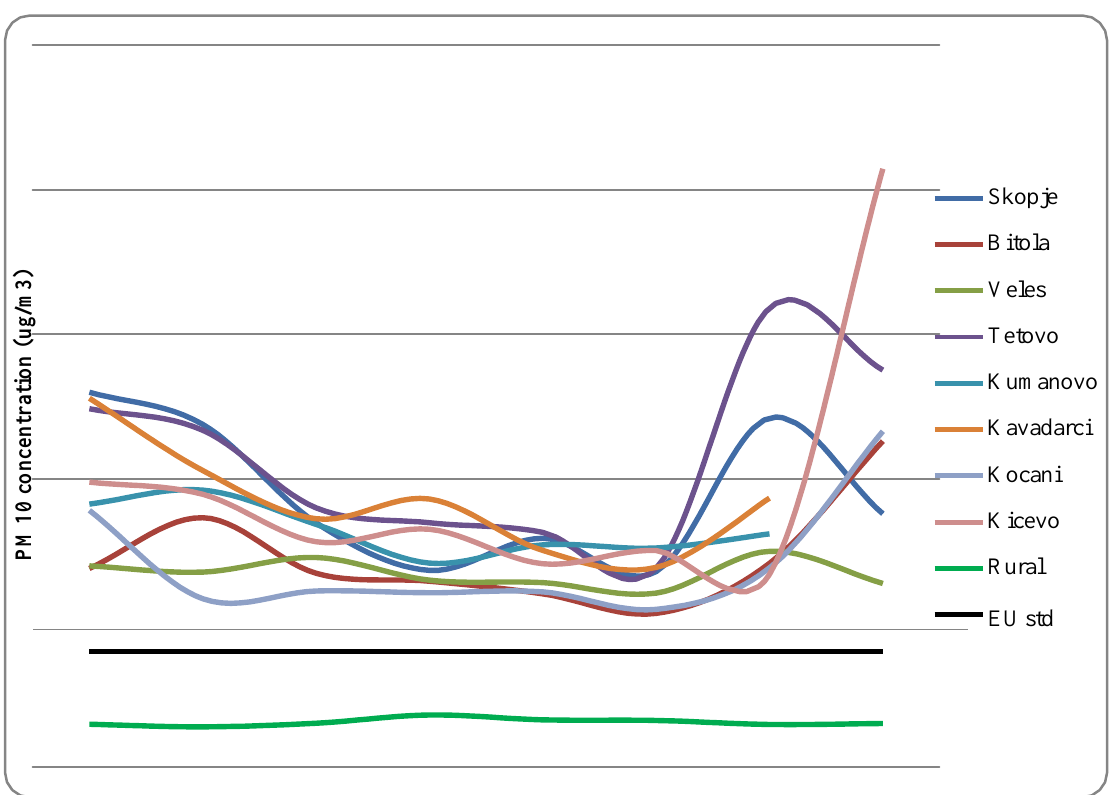
concentration at each automatic monitoring 10